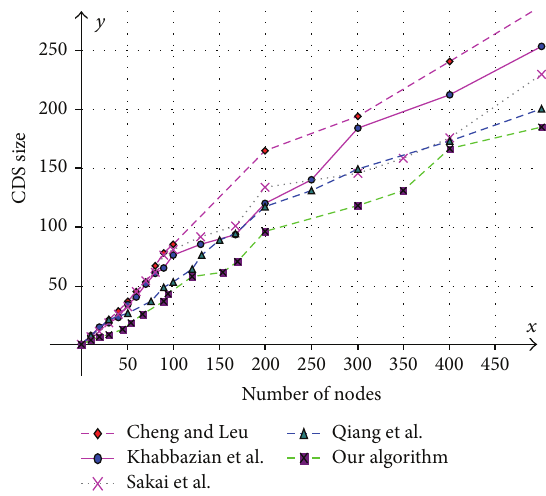
Figure 13: Number of nodes versus delivery ratio